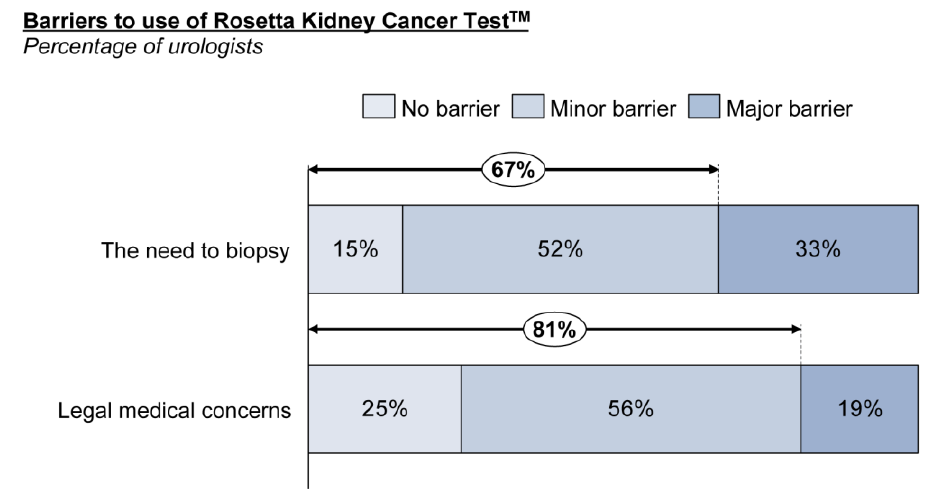
Figure 9. Biopsy and medical-legal concerns minimal among Urologists.